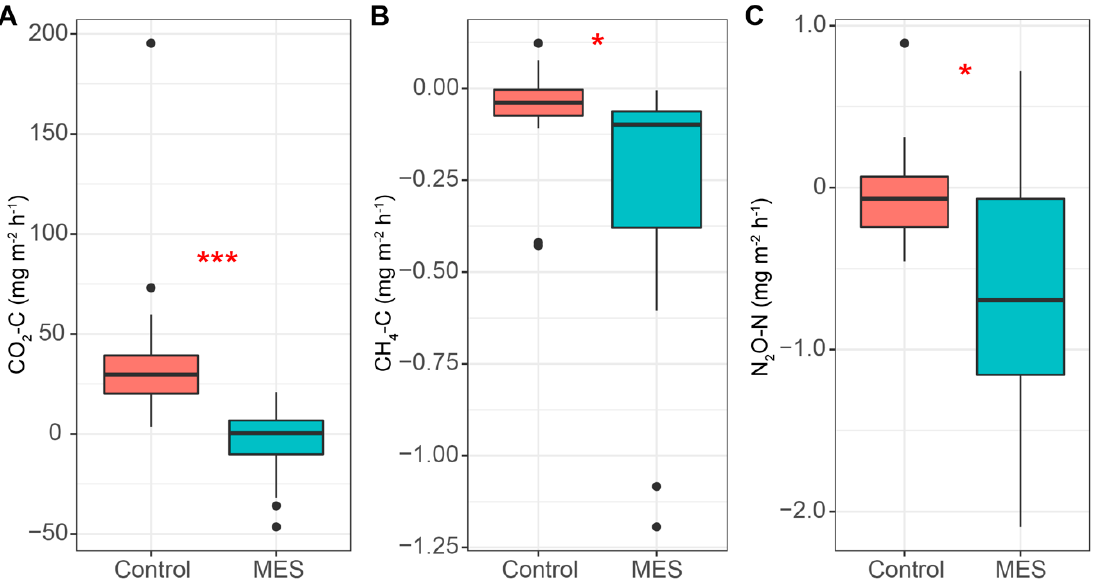
Figure 7. CO 2 ( A ), CH 4 ( B ) and N 2 O ( C ) gas fluxes in the MES and control reactors. Median, min / max, 25% and 75% quartile values are presented. The asterisks denote statistically significant di ff erences between the MES and control reactors * p < 0.05; *** p > 0.001.